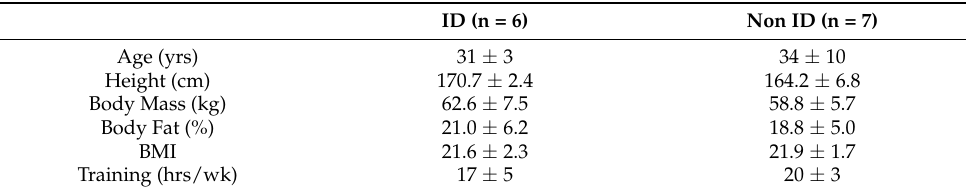
Table 1. Participant characteristics ((grouped by iron status, iron deficient (ID) and non-iron deficient (non-ID)) *.